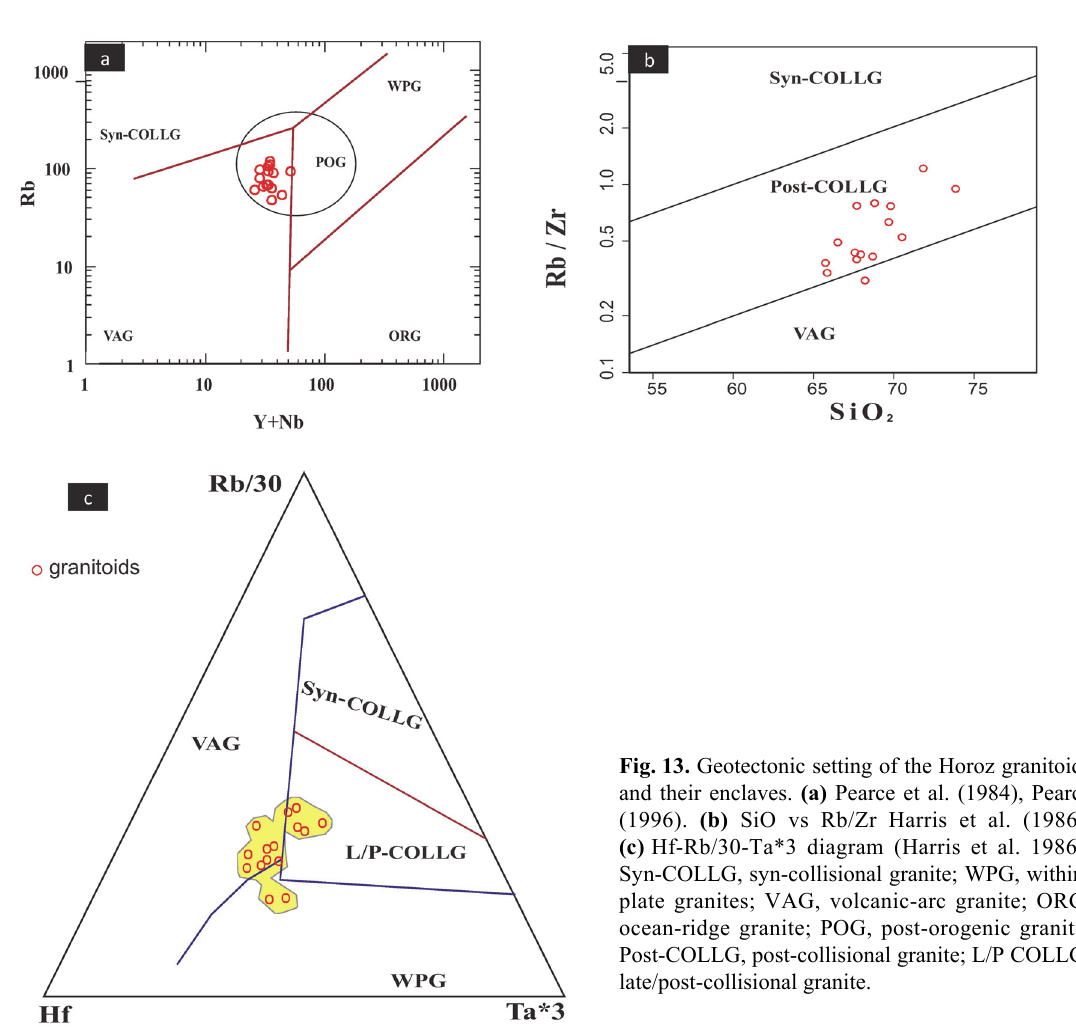
Fig. 13. Geotectonic setting of the Horoz granitoids and their enclaves. (a) Pearce et al. (1984), Pearce (1996). (b) SiO vs Rb/Zr Harris et al. (1986). (c) Hf-Rb/30-Ta*3 diagram (Harris et al. 1986). Syn-COLLG, syn-collisional granite; WPG, within- plate granites; VAG, volcanic-arc granite; ORG, ocean-ridge granite; POG, post-orogenic granite; Post-COLLG, post-collisional granite; L/P COLLG; late/post-collisional